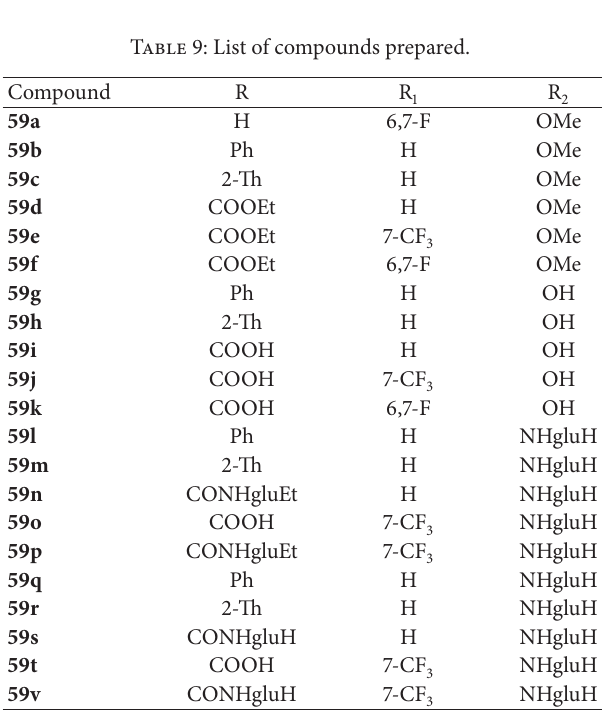
mean graph mid- 50